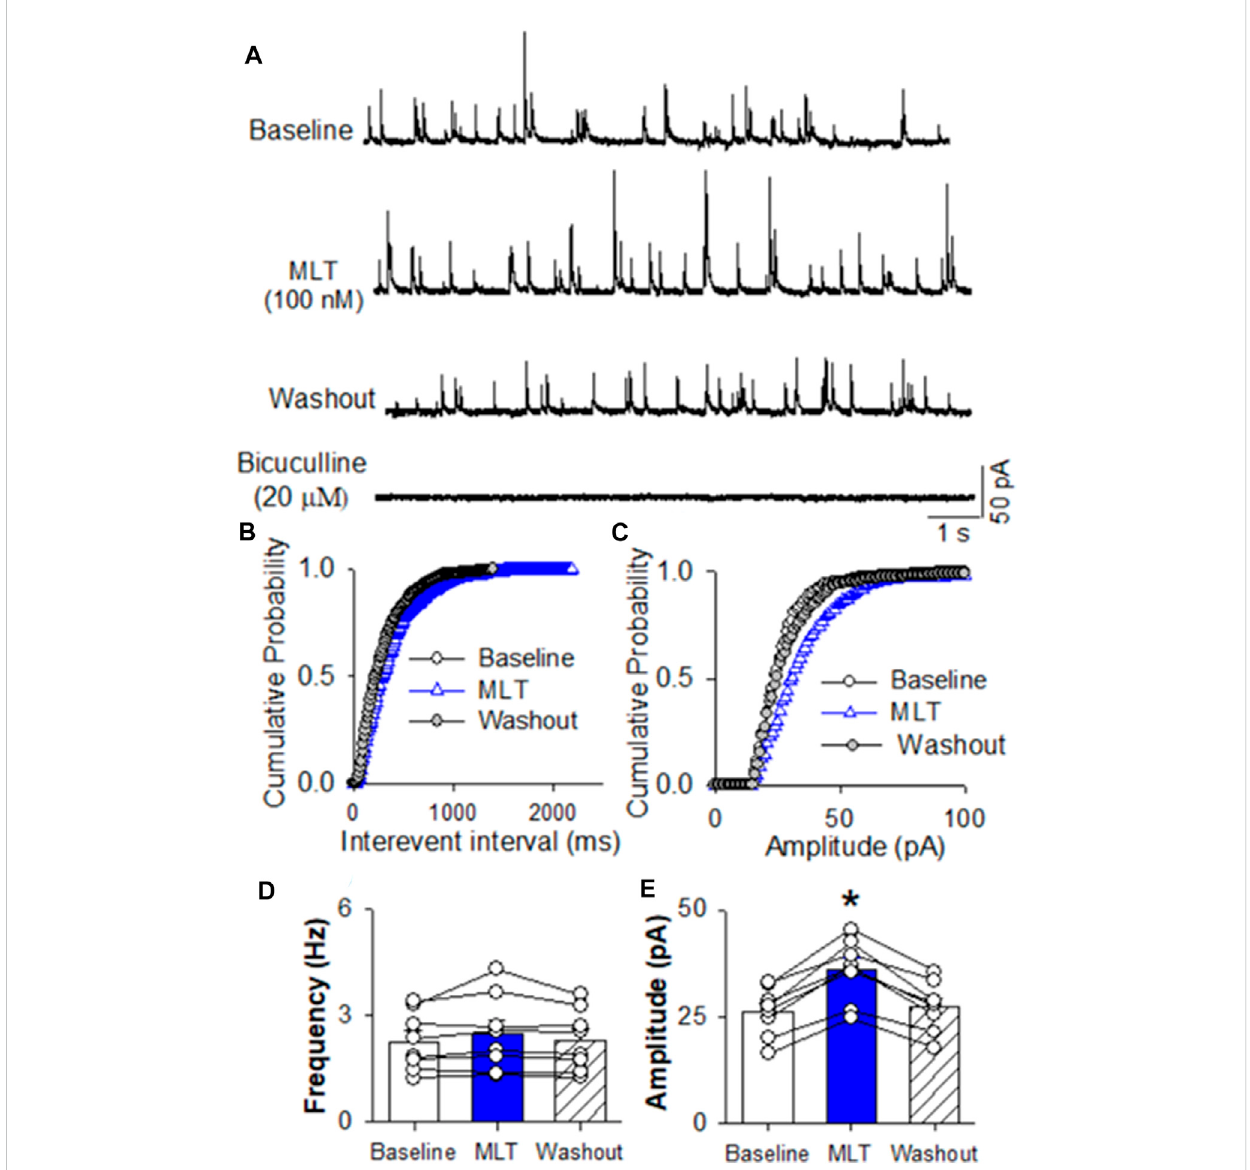
FIGURE 4 EffectofmelatoninonGABAergicminiatureIPSCsinRVLMprojectingPVNneurons (A) RepresentativetracingsfromalabeledRVLMprojectingPVN neuron show that mIPSCs recorded during control, application of 100 nM melatonin, washout, and application of 20 μ M bicuculline. Note that bicuculline completely eliminated mIPSCs. (B,C) , Cumulative probability plot analysis of mIPSCs of the same neuron showing the distribution of the interevent interval (B) and peak amplitude (C) during control, melatonin application, and washout. Melatonin shifted the distribution curve of amplitude of mIPSCs to the right ( p < 0.05; Kolmgorov — Smirnov test) without changing the distribution of the interevent-interval. (D,E) , Summary data show the effect of 100 nM melatonin on the frequency (D) and amplitude (E) of mIPSCs of 8 labeled PVN neurons. Data are presented as means ± SEM (* p < 0.05 compared with the control; Kruskal – Wallis ANOVA, followed by Dunn ’ s post hoc test). MLT,